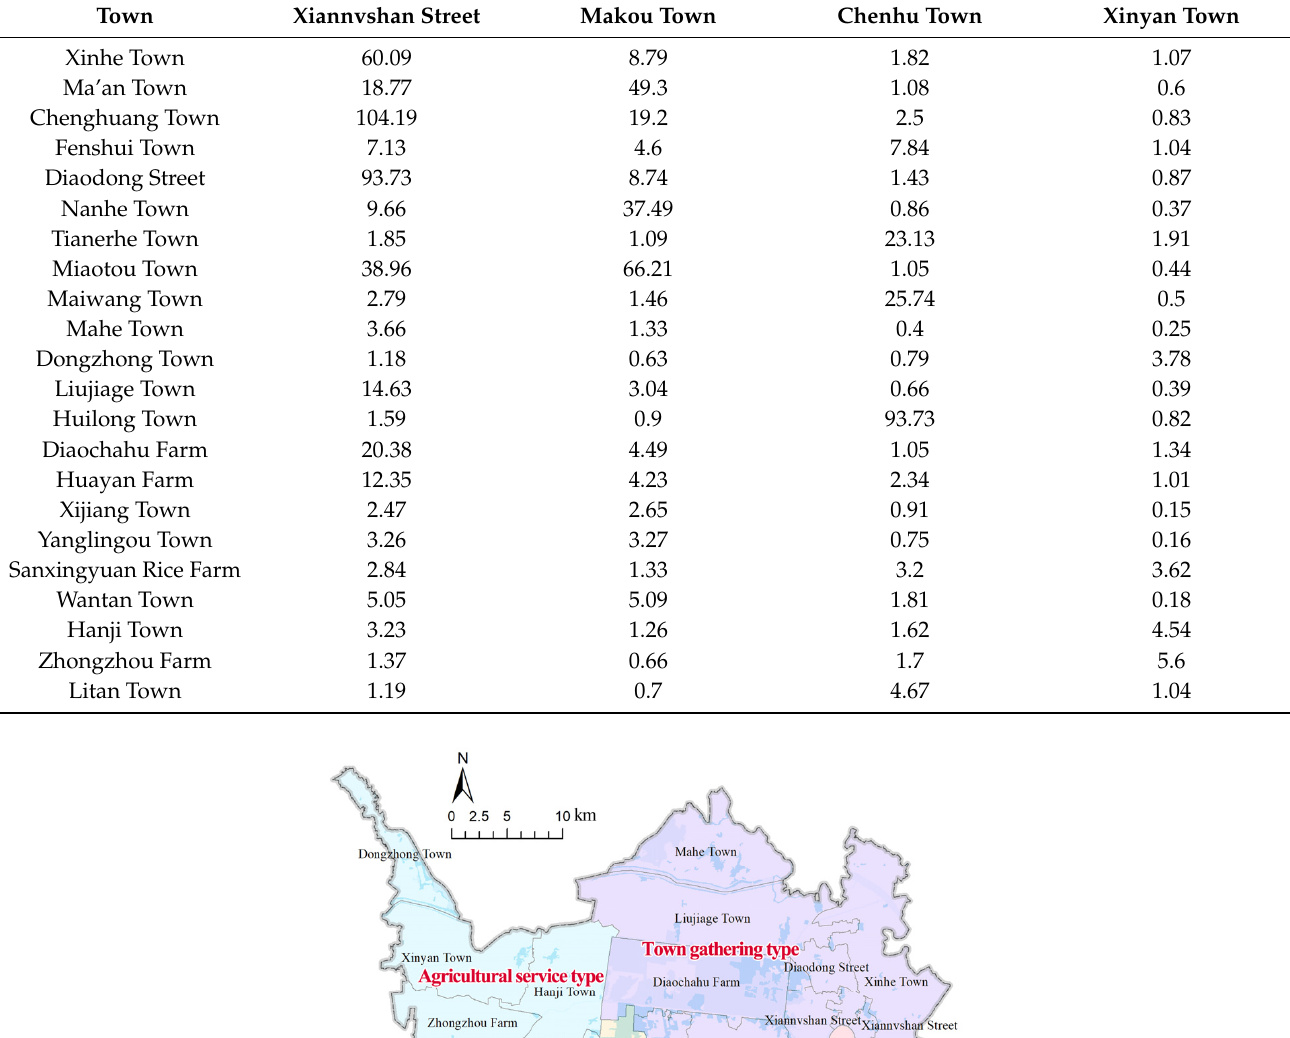
Table 4. Gravity values between 22 towns and four centers.